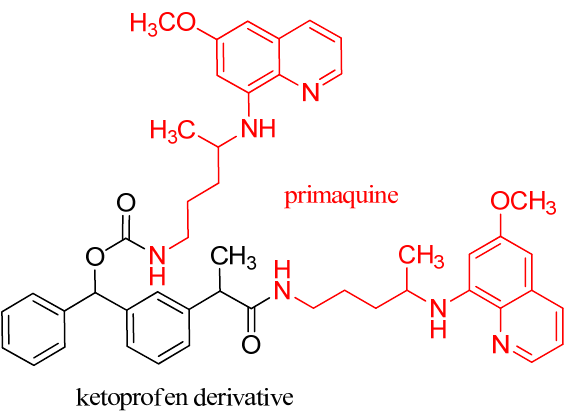
Figure 11. Hybrid of primaquine-ketoprofen (compound 5 ).